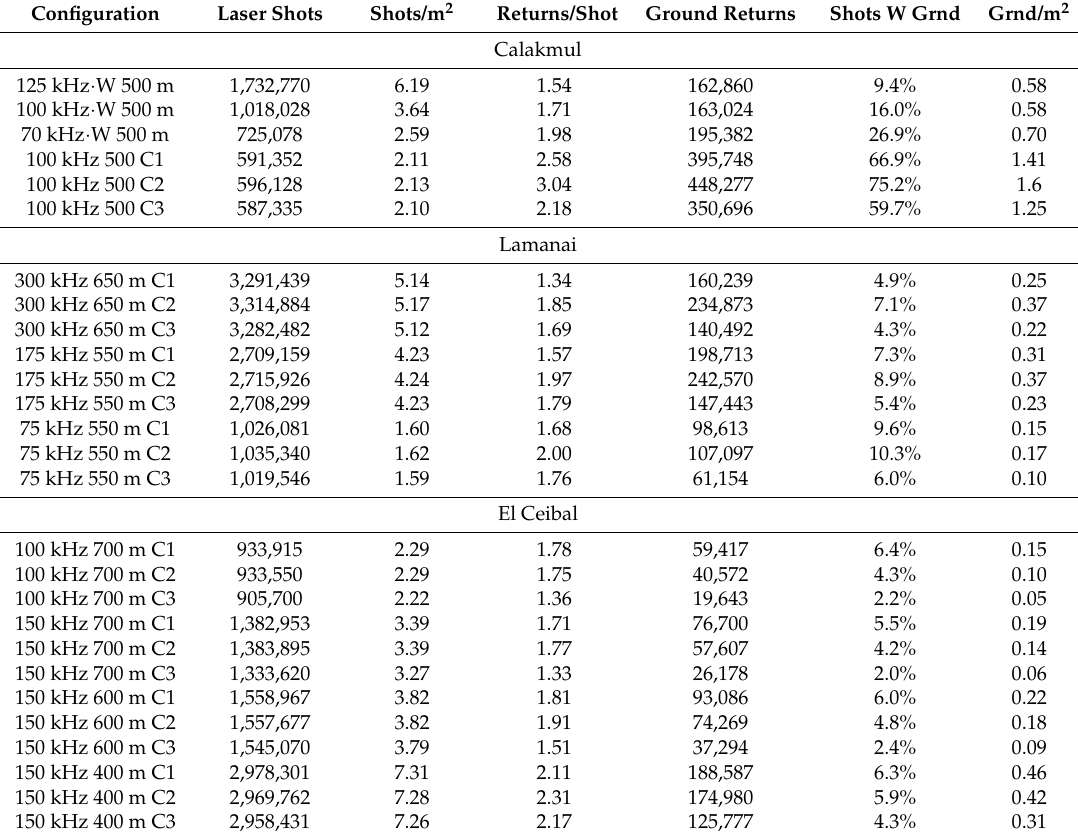
Table 6. Detailed results from the canopy penetration experiments conducted in tropical rain forests.